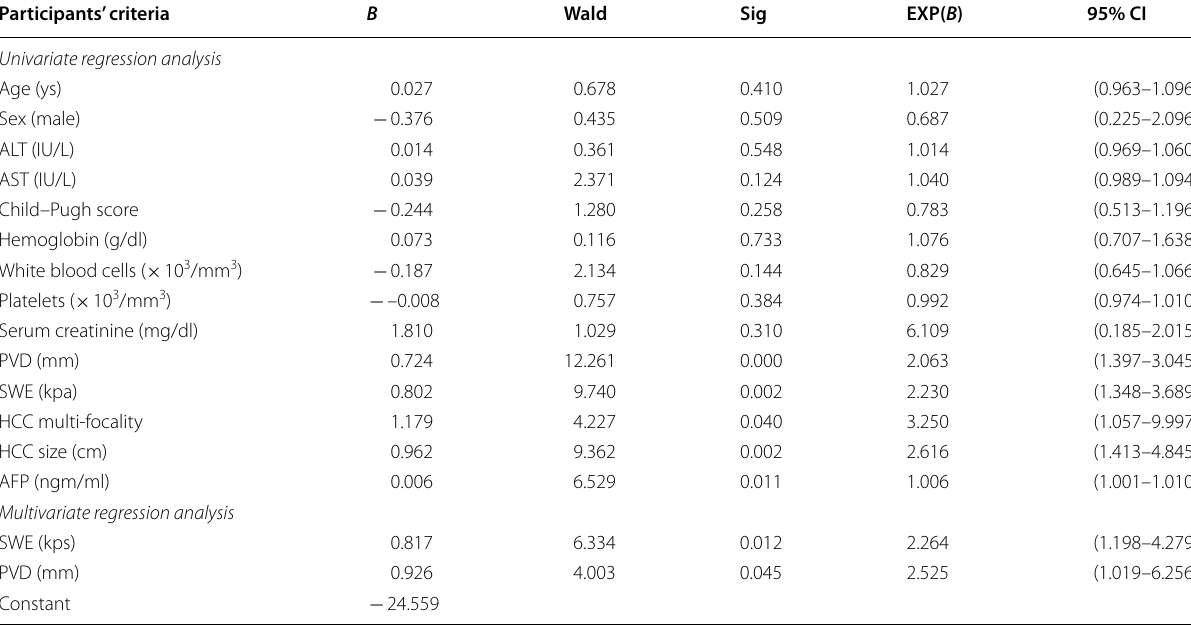
ALT Alanin aminotransferase, AST Aspartate aminotransferase, INR International normalized ratio, PVT Portal vein thrombosis, PVD Portal vein diameter, KPa Kilopascal, SWE Shear wave elastography